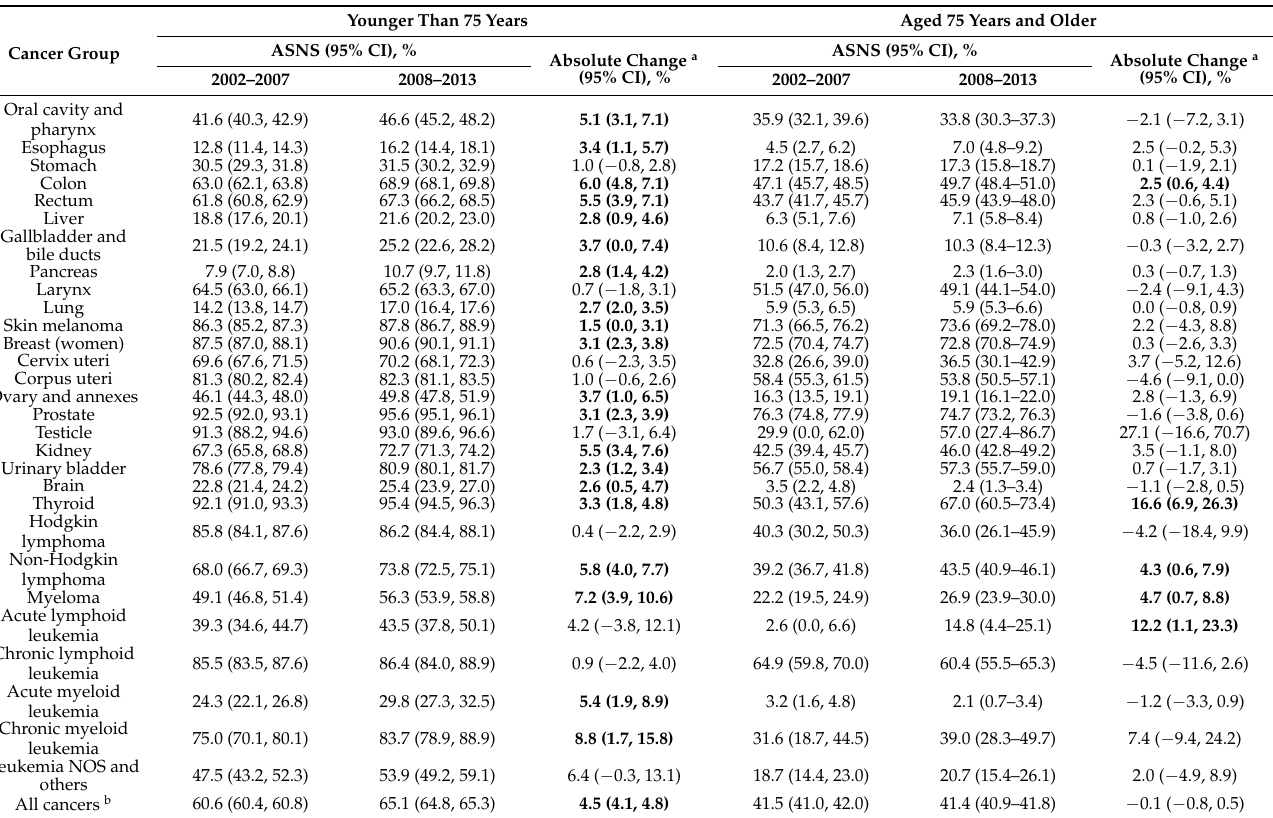
Table 5. Five-year age-standardised net survival (ASNS) in patients diagnosed with cancer in Spain in 2002–2007 and 2008–2013 and absolute change between periods according to age group at